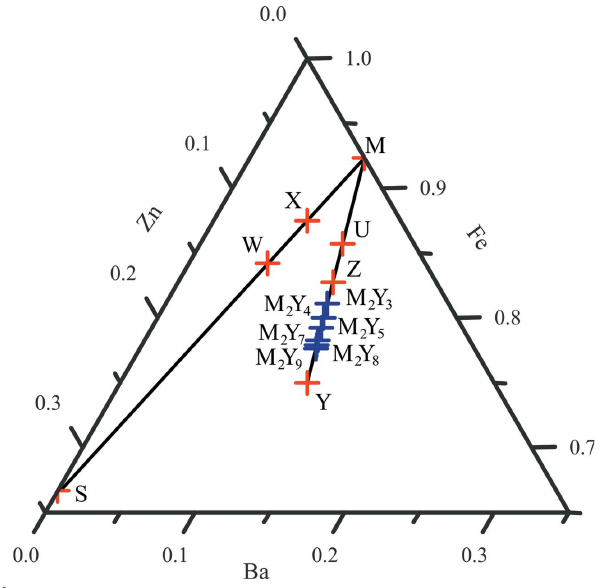
Figure 2 The Ba–Zn–Fe pseudoternary phase diagram showing the M p S and M p Y n mixed layer subgroups of the hexaferrites. The M p S subgroup lie on the line between M and the ZnFe 2 O 4 spinel (S), and the M p Y n subgroup lies on the line between M and Y. The compositions of the hexaferrites with previously reported crystal structures (Table 2) are shown in red, and those of the hexaferrites with crystal structures reported in this work (Table 4) are shown in blue.